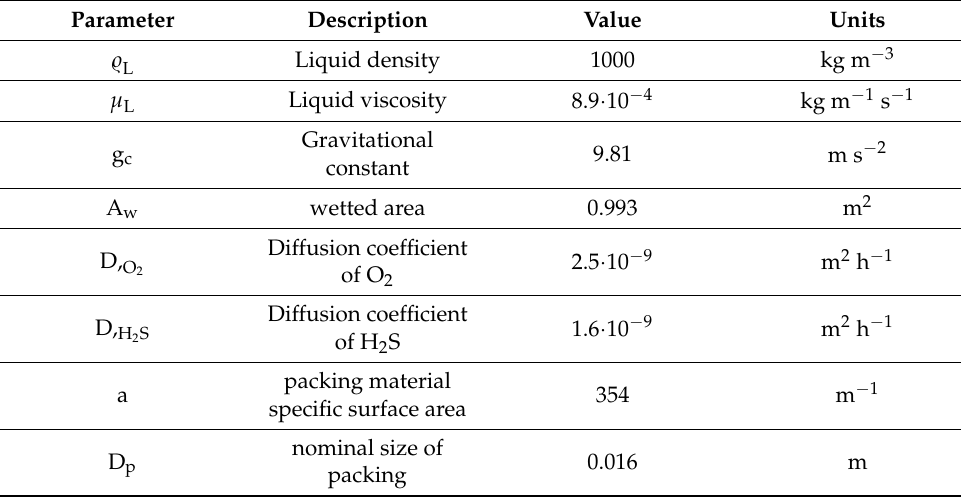
Table A2. Constants needed for the Onda mass transfer